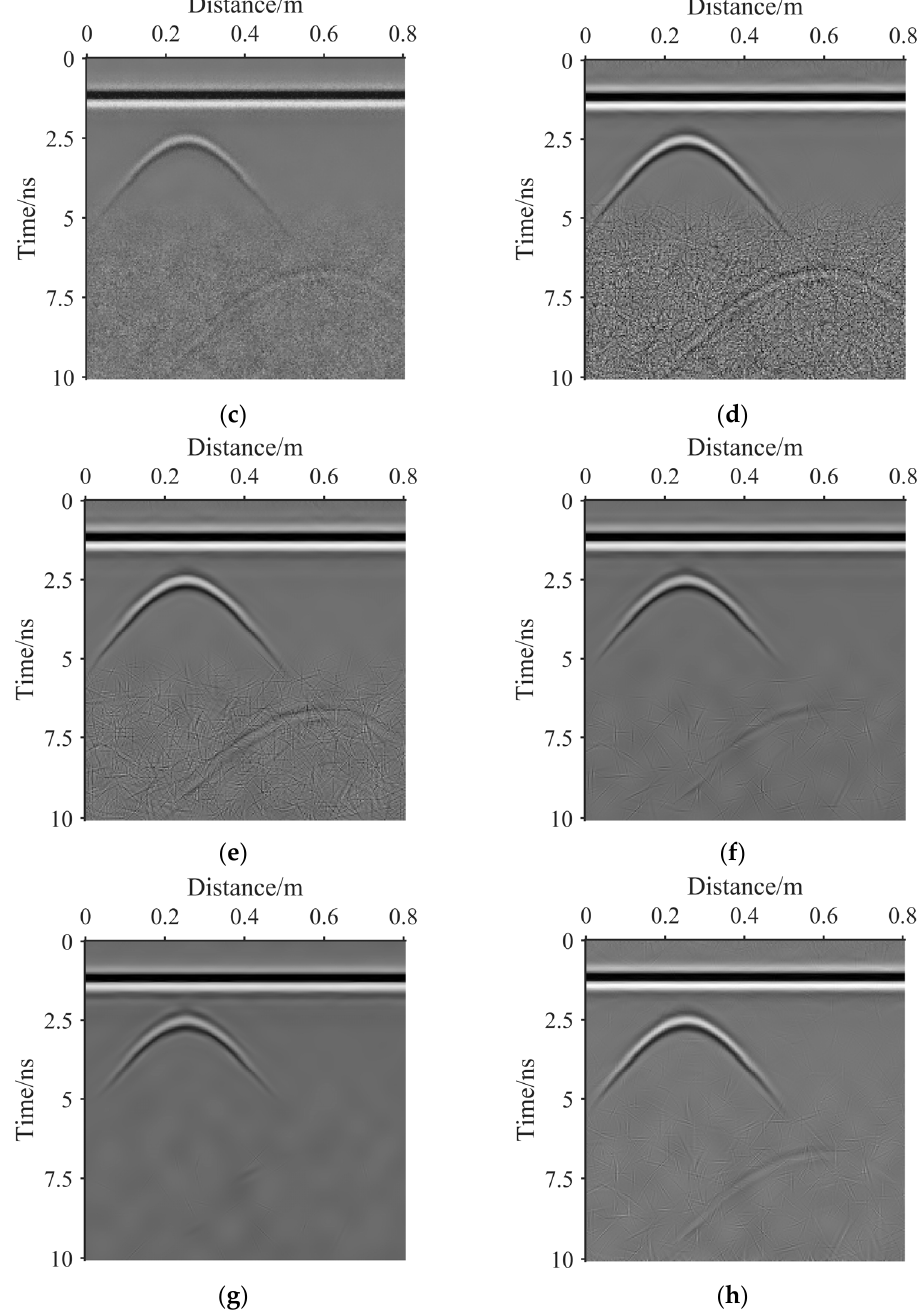
Figure 8. ( a ) The simulated noisy GPR image 1. ( b ) The result of bilateral filter. ( c ) The result of guided filter. ( d ) The result of NSST-1. ( e ) The result of NSST-2. ( f ) The result of NSST-3. ( g ) The result of NSST-4. ( h ) The result of the proposed method.